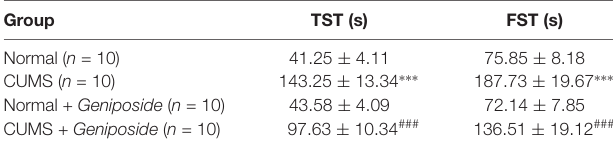
TABLE 2 | Effects of geniposide on chronic unpredictable mild stress (CUMS)-induced behavioral abnormalities.